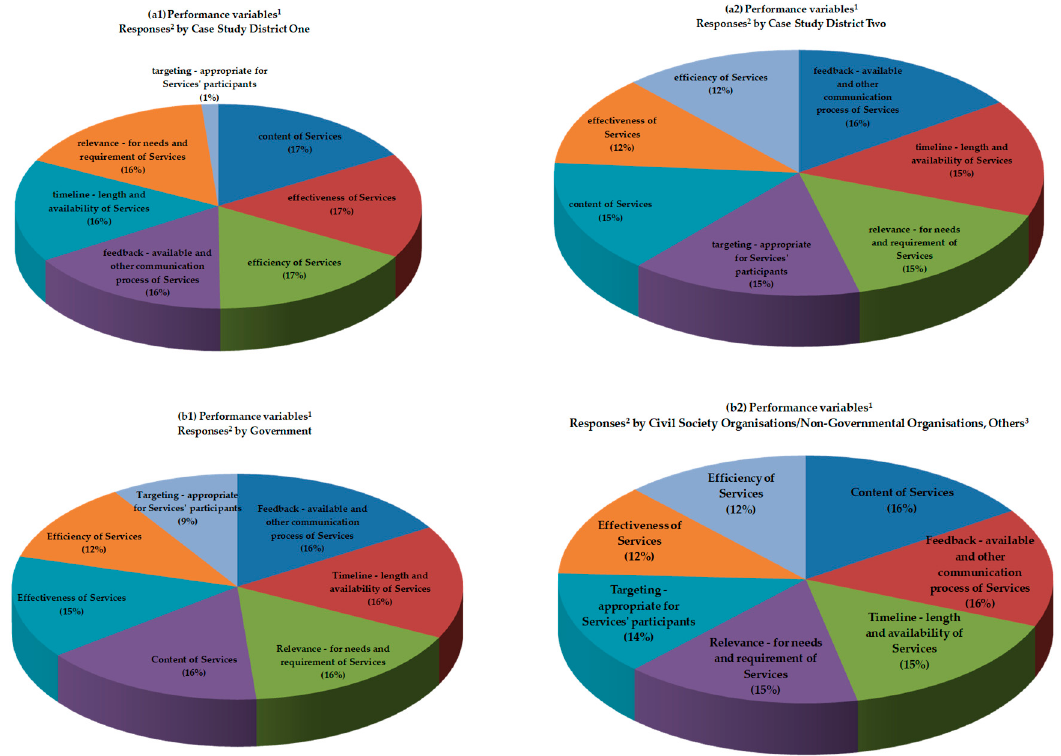
Figure 2. Smallholder farmers’ perspectives on Advisory Extension Services by performance